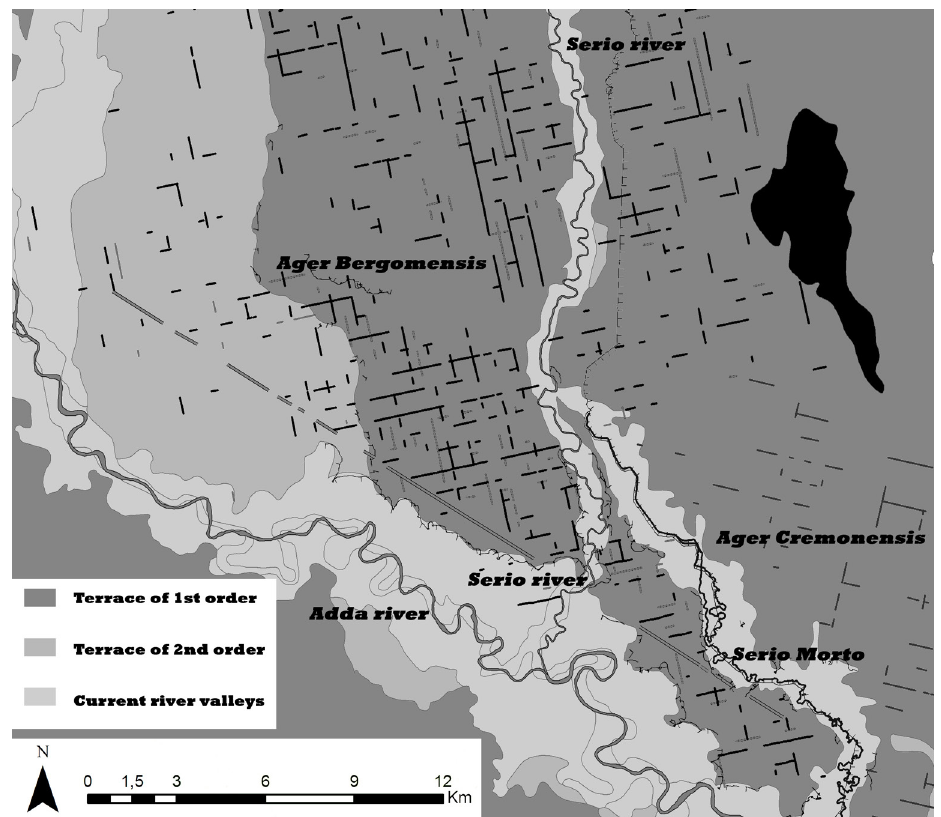
Figure 10: Traces of centuriation between Adda river and Serio